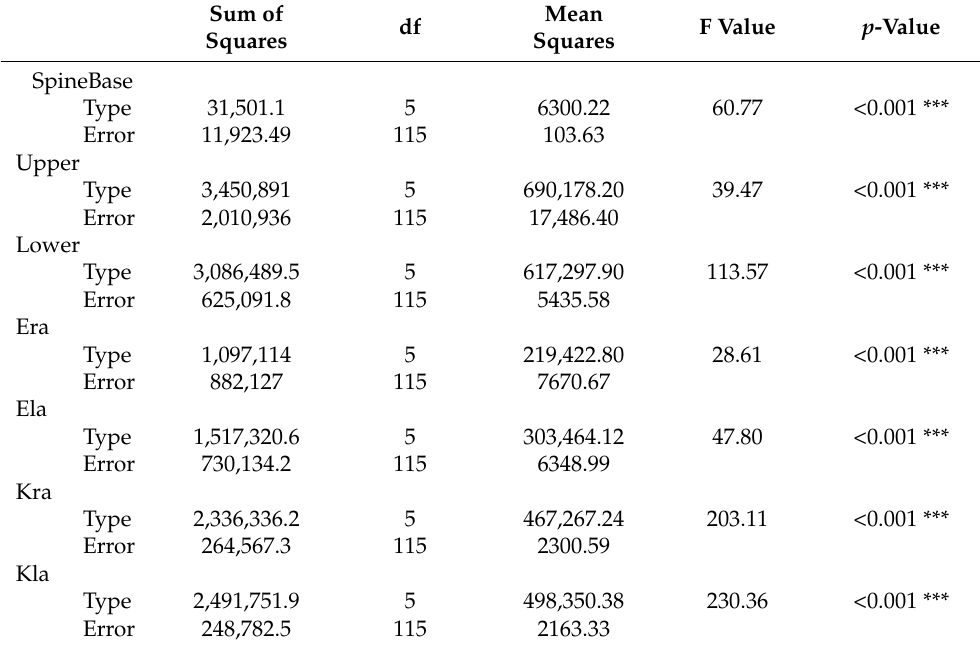
Table 3. Repeated measure ANOVA on Kinect data.